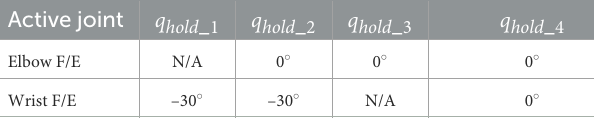
TABLE 1 Holding position of inactive joints throughout testing. Active